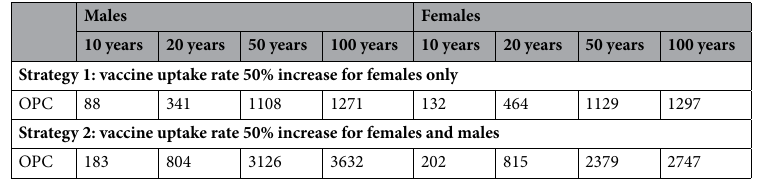
Table 1. Cumulative cases prevented by different strategies. Female and male vaccination includes age 13 to 26